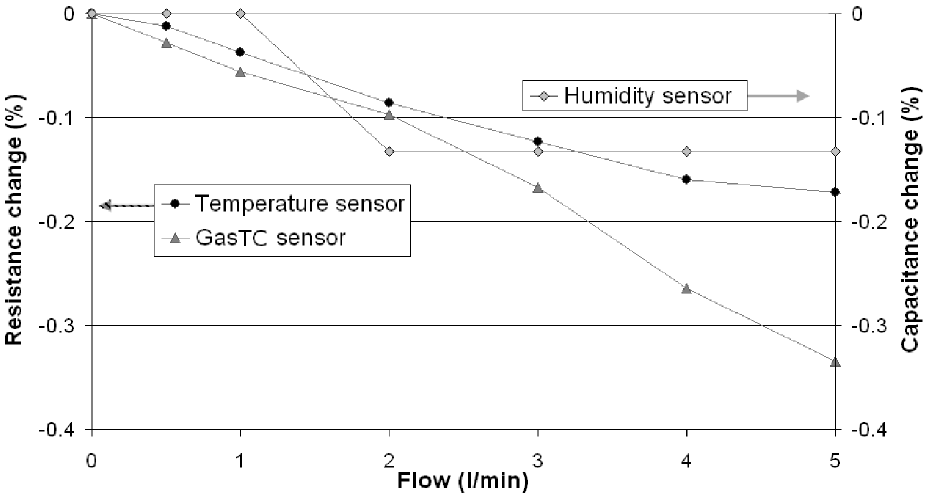
Figure 18. Influence of dry air flow on the surface of the MEMS multisensor